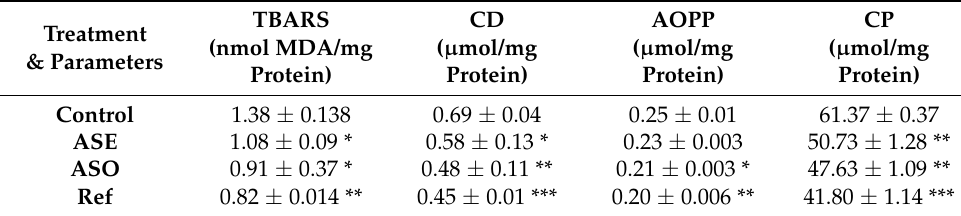
Table 2. Effects of Allium subhirsutum L. extract (ASE), Allium subhirsutum L. oil and the reference drug “Cytolcentella ® ” on oxidative stress markers of granulation tissue by estimation of TBARS, CD, AOPPA and CP